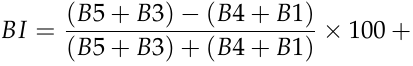
( b ) Figure 5. Bar soil index (BI). ( a ) BI for year 1989; ( b ) BI for year 2017 Shadow Index (SI). The use of this index highlights the three-dimensional character- istics of the forest by placing the focus on the shaded areas of the forest canopy. It is based on the low brightness of the visible bands. Through this process, younger tree structures